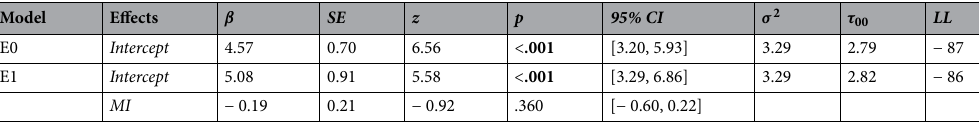
Table 5. GLMM analysis, influence of the number of memory items on the selection accuracy. β fixed effect 2 coefficient, LL log-likelihood, σ variance of level-1 residual errors, τ 00 variance of level-2 residual errors. Significant values are in